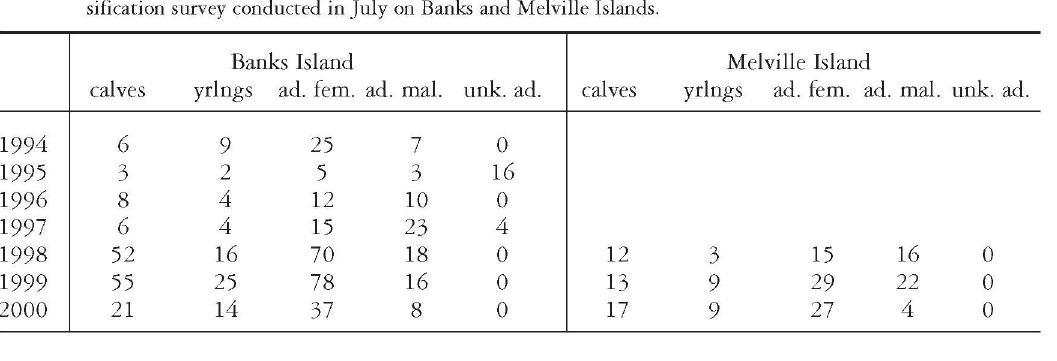
Melville Island